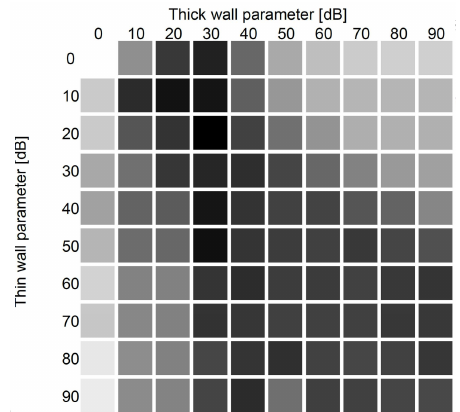
Figure 4. Accuracy of the method while using different parameters for the parameter describing the effect of thin, plaster walls (vertical axes) and thick, brick-and-concrete walls (horizontal axes) on the signal propagation. The darker the color, the higher the accuracy with those parameters.